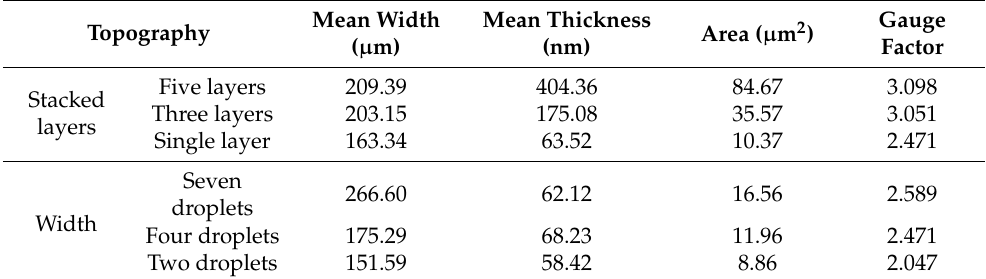
Table 2. Measured widths, thicknesses and corresponding gauge factors of printed strain-gauge patterns.